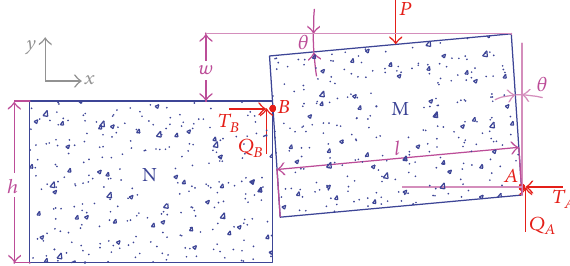
Figure 10: “Step beam” structureof the rock block M and rock block